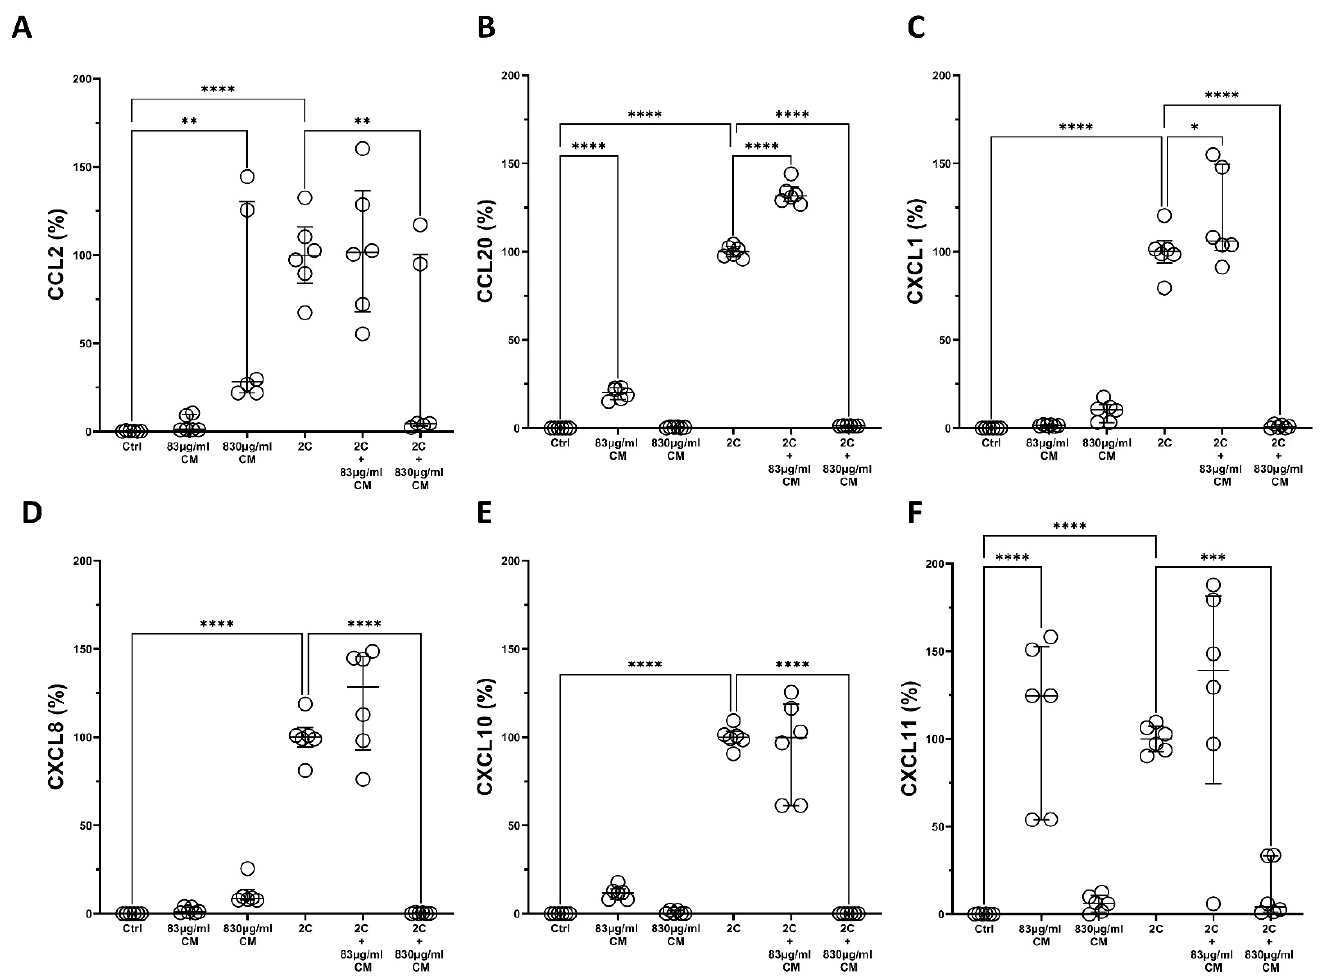
Figure 4. The effect of CM on chemokine protein expression in hPSMs, which are under pro-inflammatory stimuli. The CM inhibit the protein expression of chemokines CCL2 ( A ), CCL20 ( B ), CXCL1 ( C ), CXCL8 ( D ), CXCL10 ( E ) and CXCL11 ( F ) in a dose-dependent way. 2C: IL-1 α 5 ng/mL + TNF- α 50 ng/mL; 830 µ g/mL total protein of CM; 83 µ g/mL total protein of CM. Results are presented as median with interquartile range. **** p < 0.0001; *** p < 0.001; ** p < 0.01; * p < 0.05. N = 3.